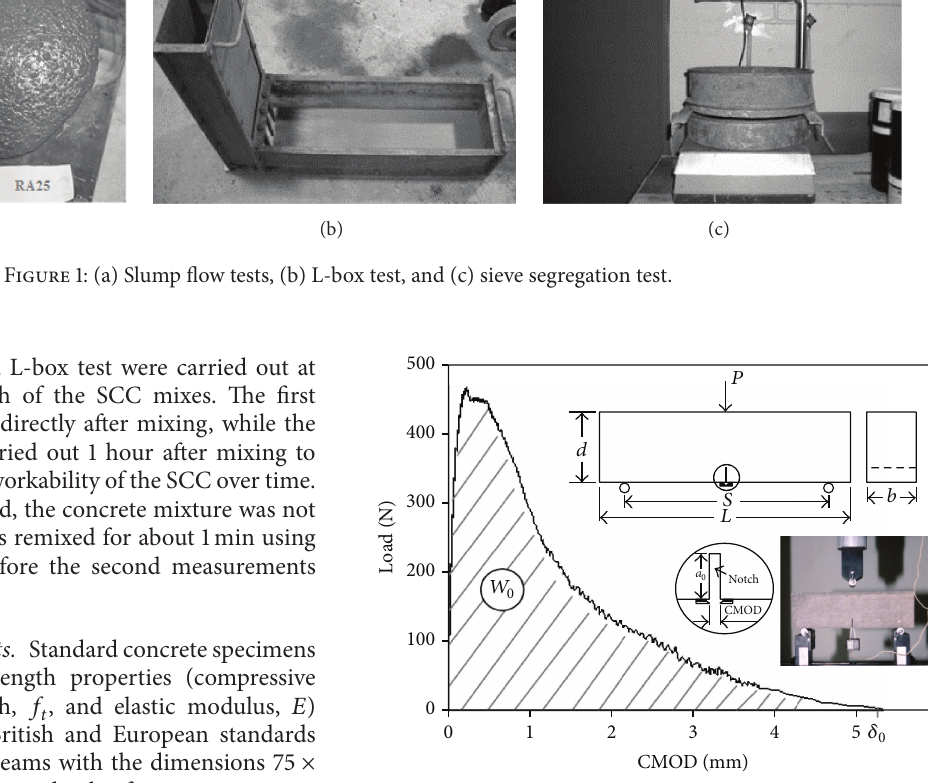
Figure 2: Typical experimental load-CMOD plot with testing configuration (span length = 200